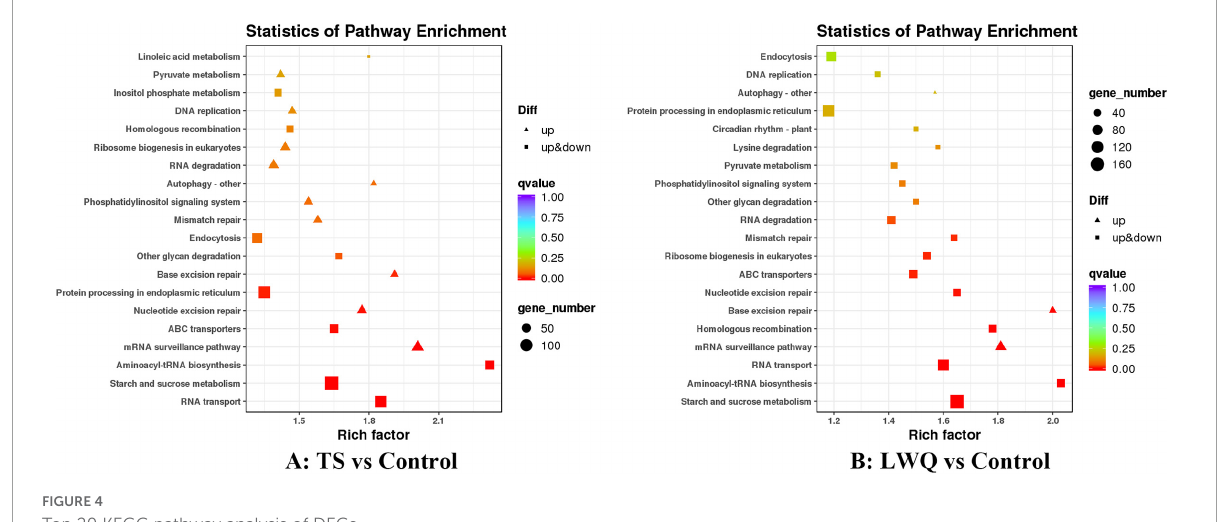
FIGURE4 Top 20 KEGG pathway analysis of